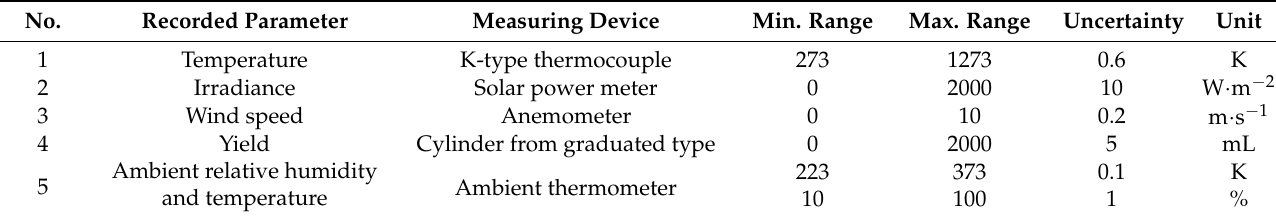
Table 3. The information about the used devices to capture experimental data